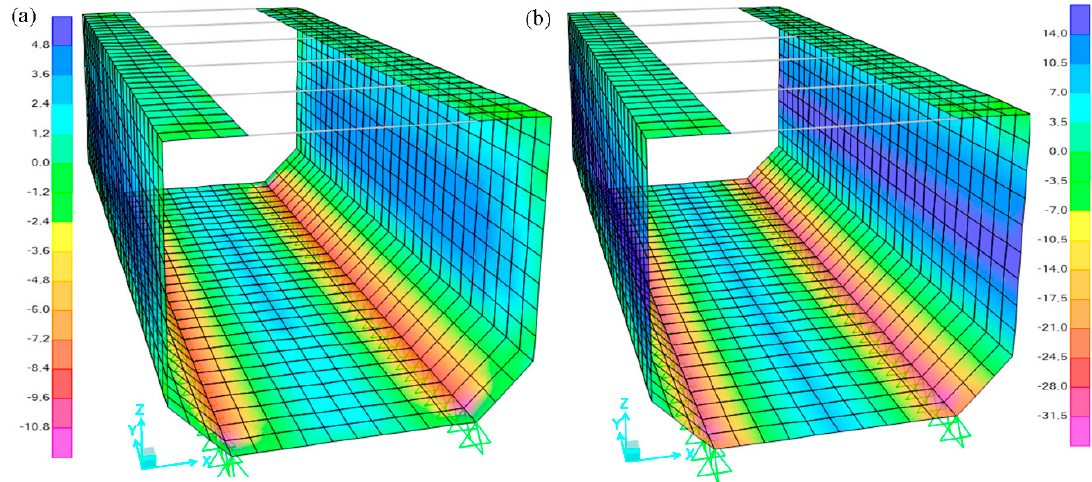
Figure 7. Bending moment distribution (mkN/m) for the combination C 1 : ( a ) M 11 and ( b ) M 22 .